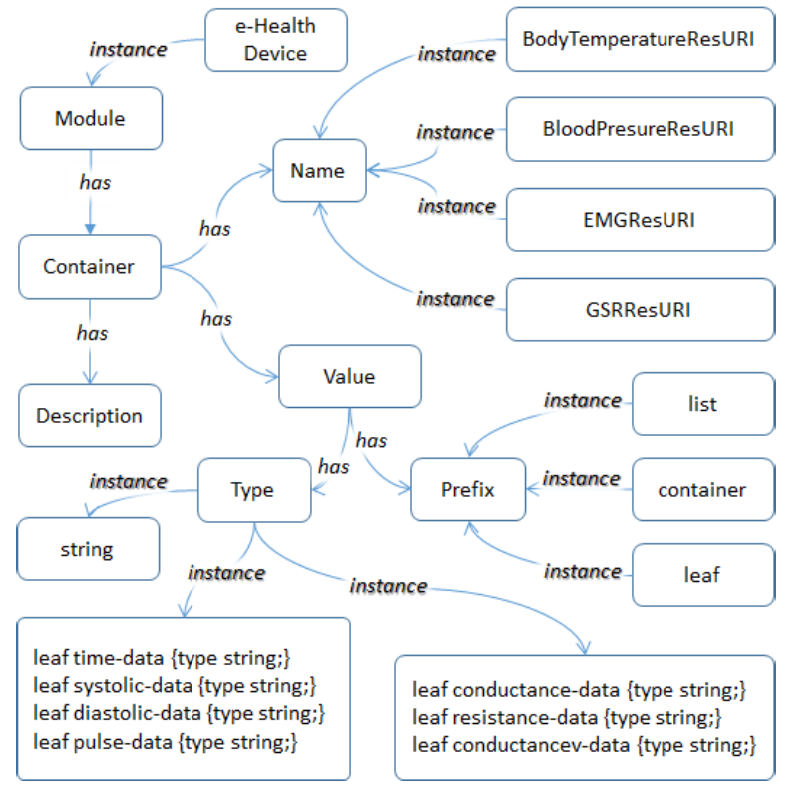
Figure 2. Ontology of the YANG-based semantic model for e-Health sensors.